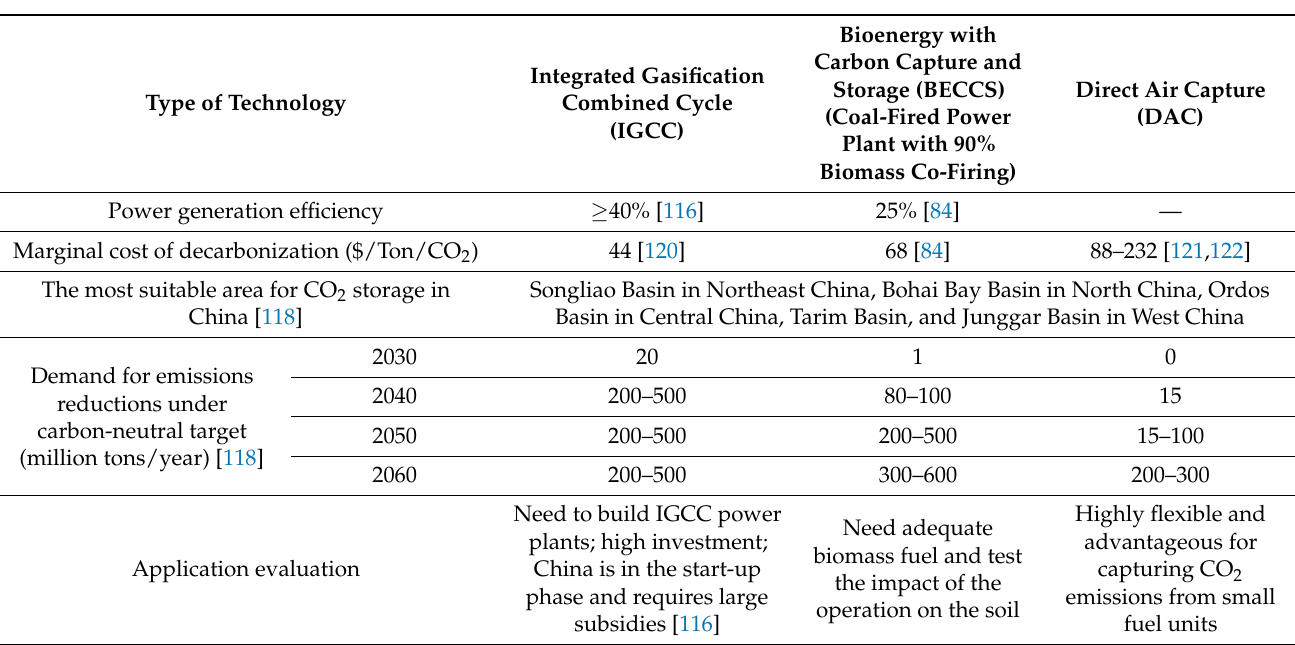
Table 5. Comparison of different CCS